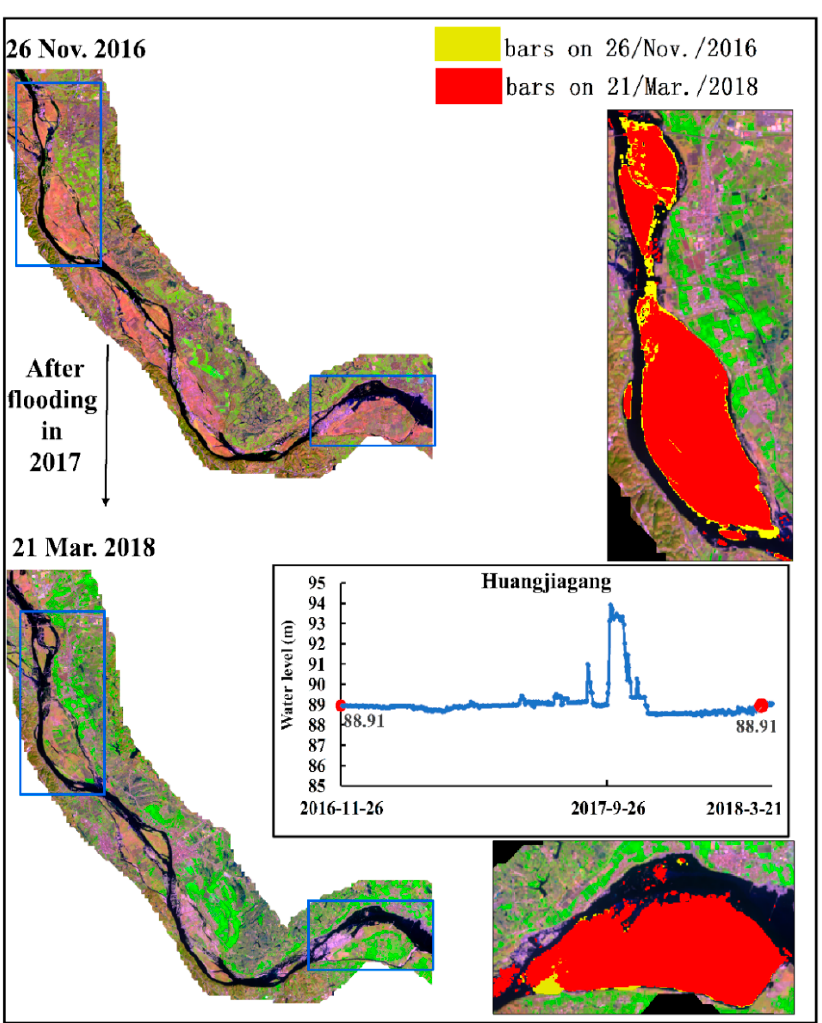
Figure 11. Example of channel bar change in both area and shape after a flooding event.